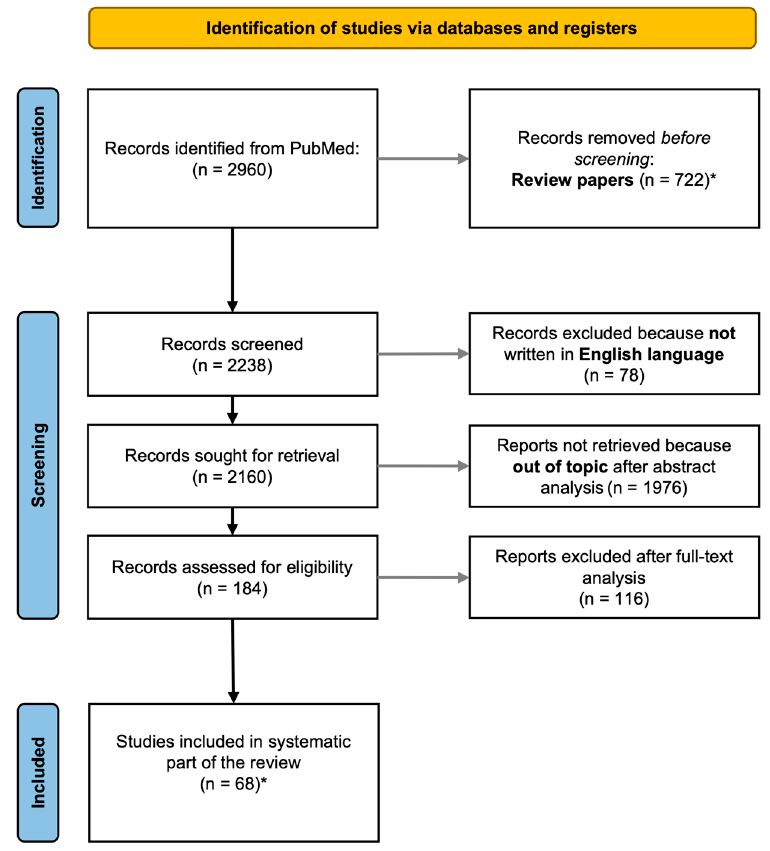
Figure 1. The workflow of the literature search is reported in the flowchart. The search was performed on pubmed.ncbi.nlm.nih.gov using the key words reported in the paragraph “Methods”. A final set of 68 papers were used to write the systematic part of the review. * Articles cited as [3–10] are review papers used to provide a clinical and pharmacological background and are thus not included in the final count.